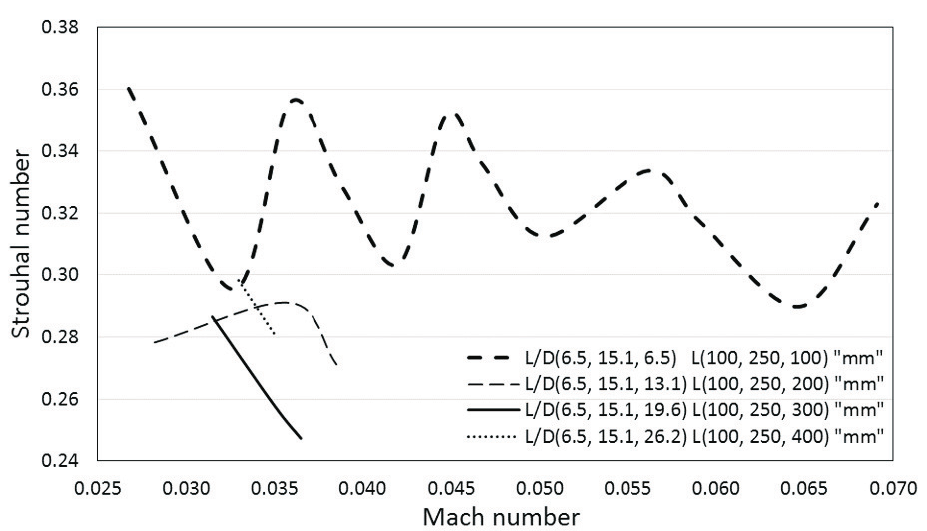
Figure 6. Strouhal number St plotted against Mach number M for L up = 100 mm, L corr = 250 mm, and L dw = 100–400 mm. Table 3. Mach number range, corresponding Strouhal number ( St ) range and maximum Strouhal number for each pipe configuration in Case a-I.